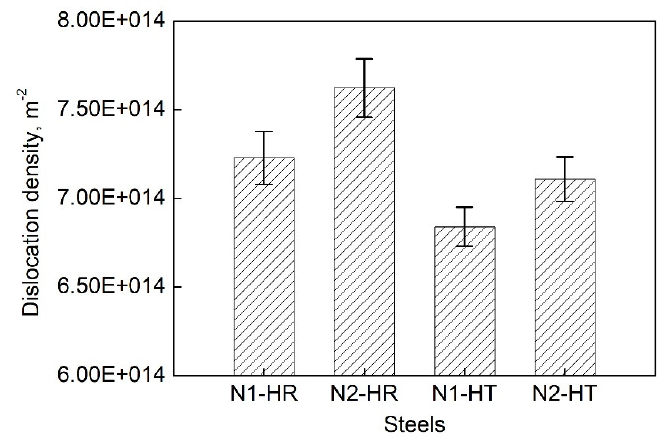
Figure 8. The dislocation density of steels.